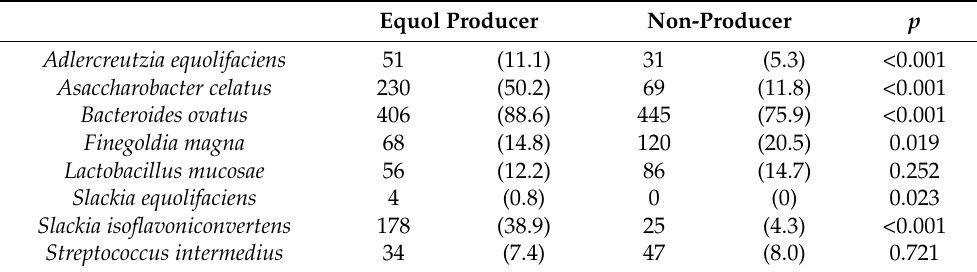
Table 3. Prevalence of intestinal bacteria species producing